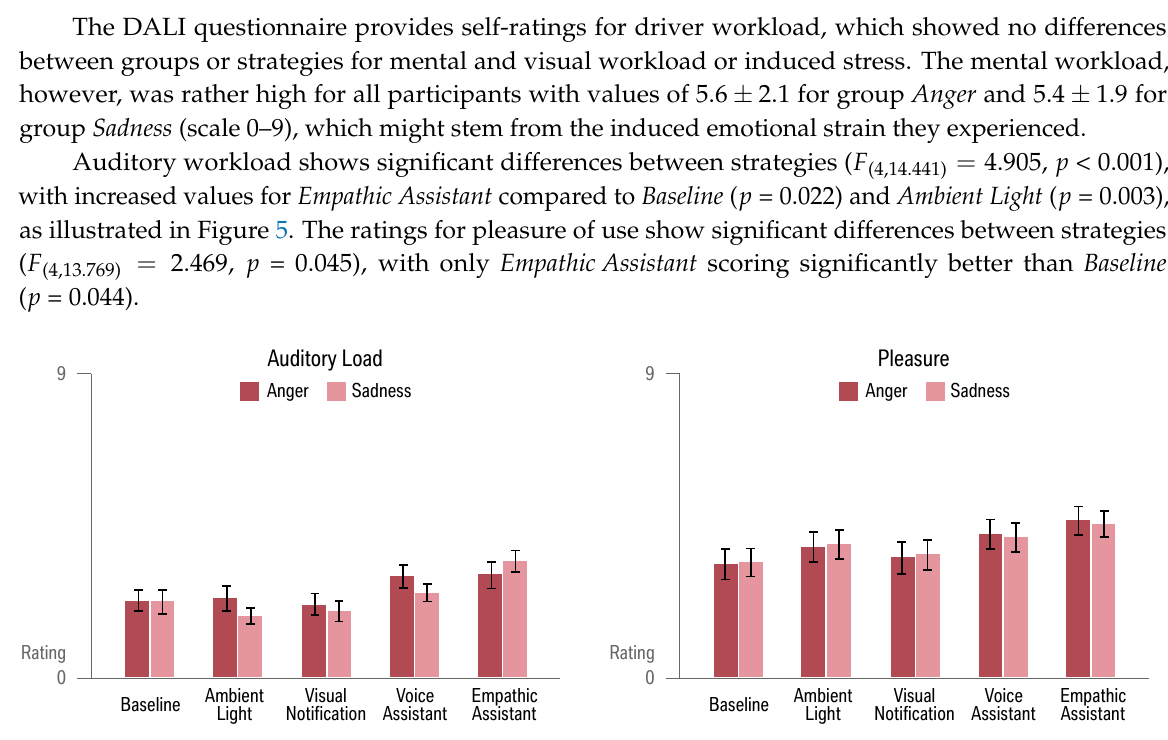
Figure 5. The ratings for auditory load and pleasure show significant differences between strategies but not emotions. Concept Empathic Assistant induces the highest auditory load but is also rated as most pleasant to interact